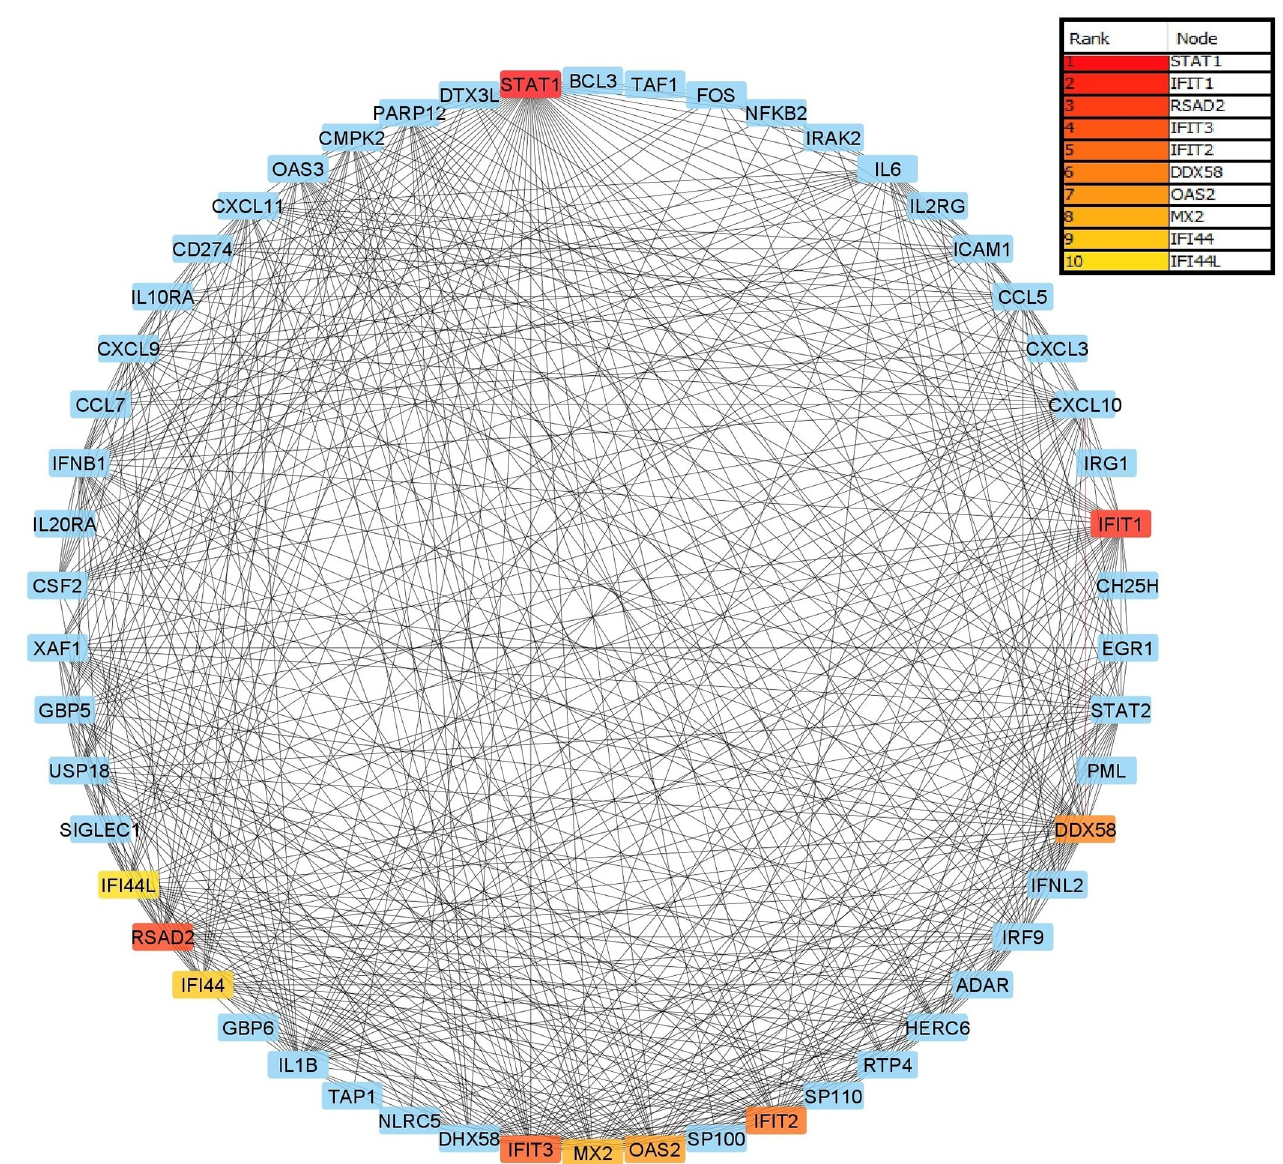
Fig 6. The cytoHubba plug-in in Cytoscape was used to search the list of top 10 genes from the PPI network with node degrees indicating hub differentially expressed genes, including STAT1, RSAD2, IFIT1, IFIT3, IFIT2, DDX58, OAS2, MX2, IFI44 and IFI44L.